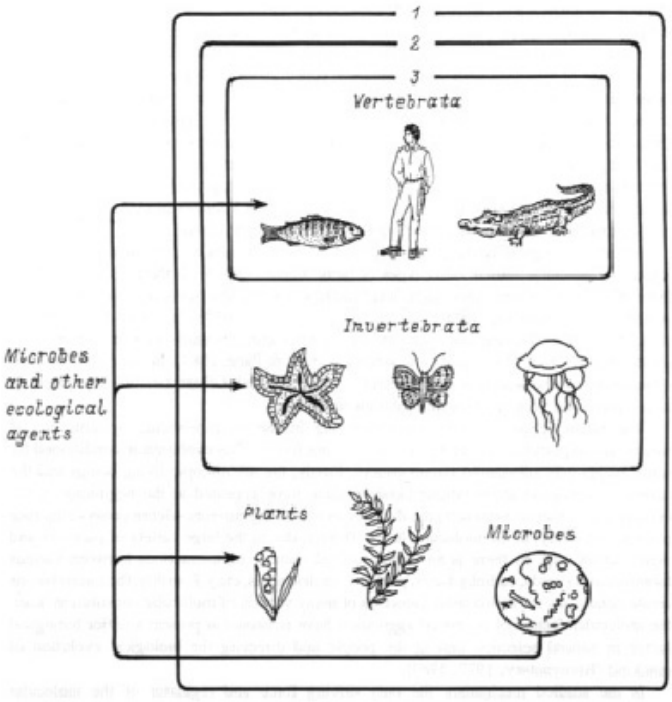
FIGURE 2. The main systems of immunogenesis: constitutional (1), phagocytic (2) and lymphatic